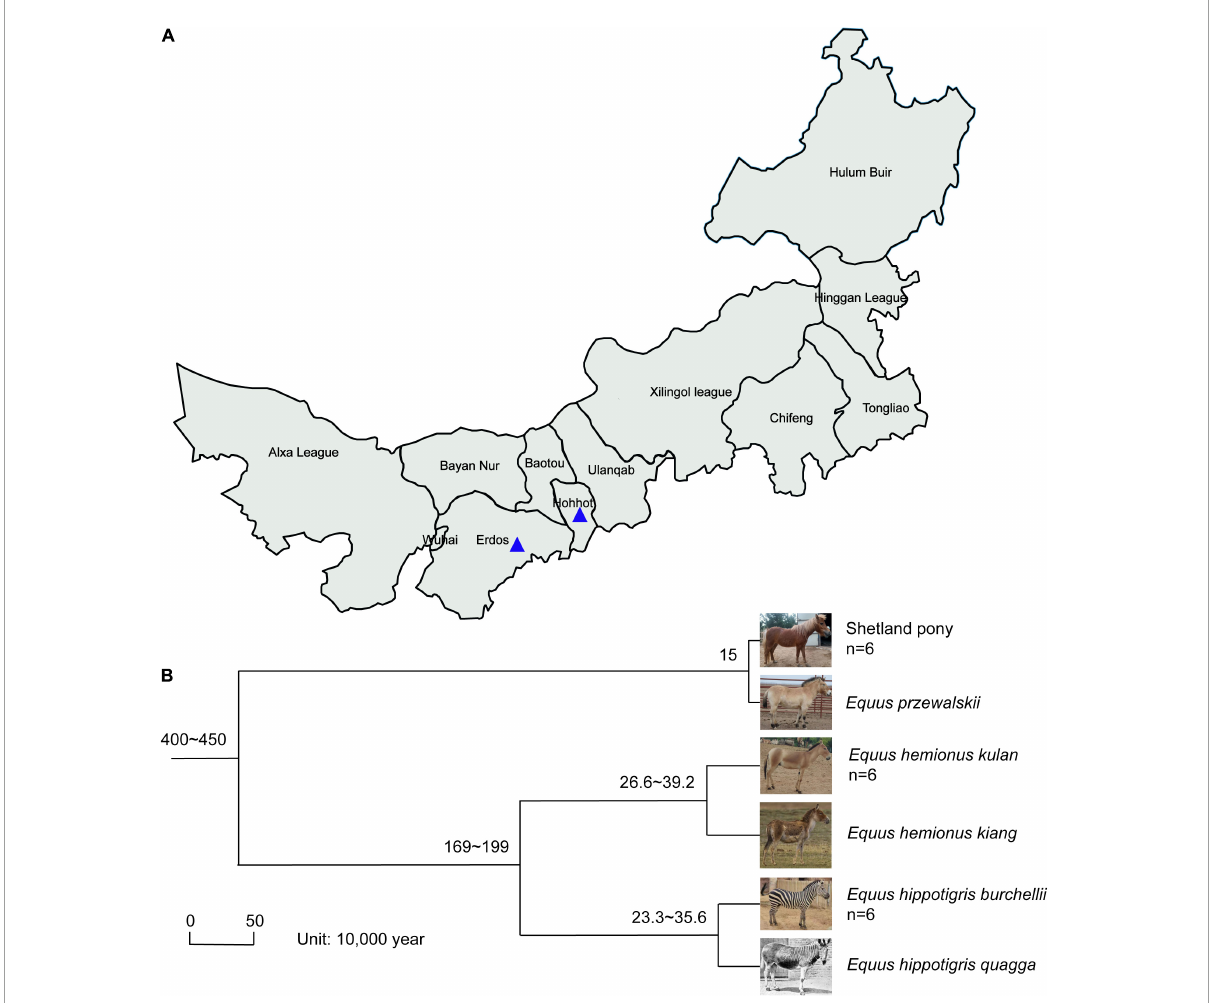
FIGURE1 Location of fecal sample collection and host phylogeny plot; Photographs (A) ; of Equus hemionus kulan and Equus hippotigris quagga in panel (B) are from Baidu search engine. The numbers represent the confidence intervals of the age of differentiation; n represents the sample size.